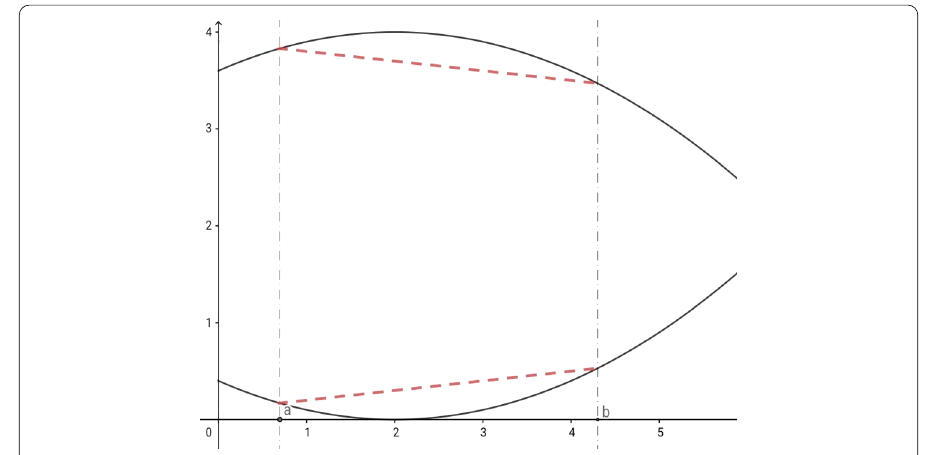
Figure 1 Convex interval-valued function F = [ f – , f + ]. The red dotted line represents θ F ( a ) + (1 – θ ) F ( b